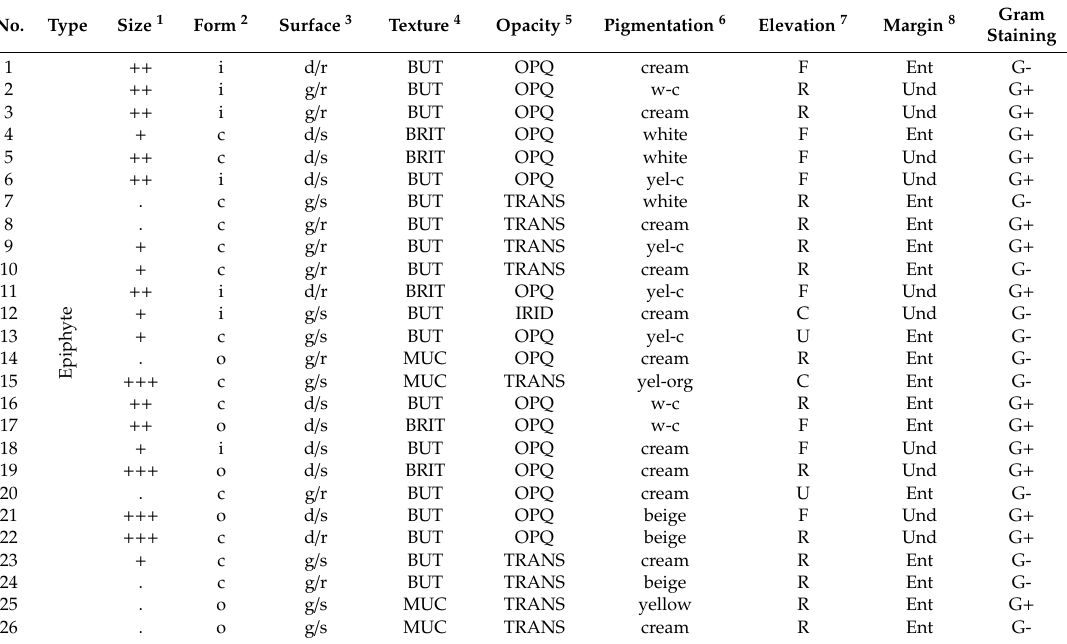
Table 2. Morphological traits of the